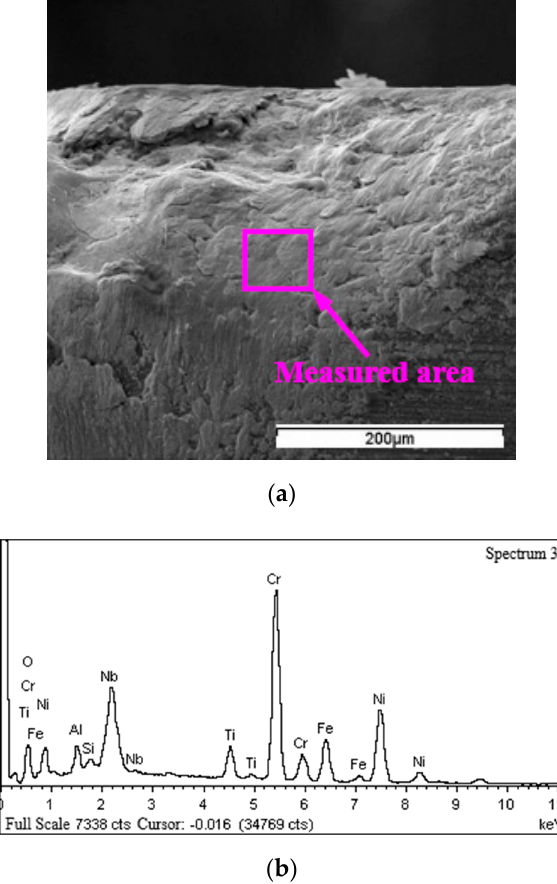
Figure 12. Adhered material at the notching area of SX9: ( a ) SEM micrograph; ( b ) EDS spectrum. Table 4. Composition of adhered material at the measured